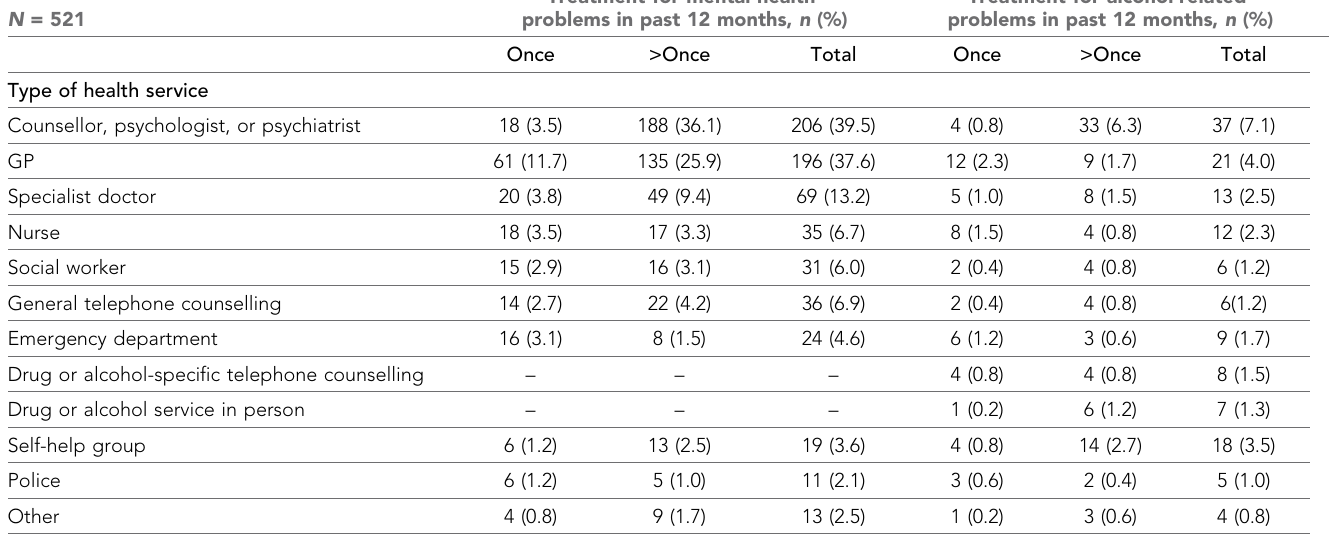
Table 1. Twelve-month treatment utilisation for mental health and alcohol-related problems by service provider N =